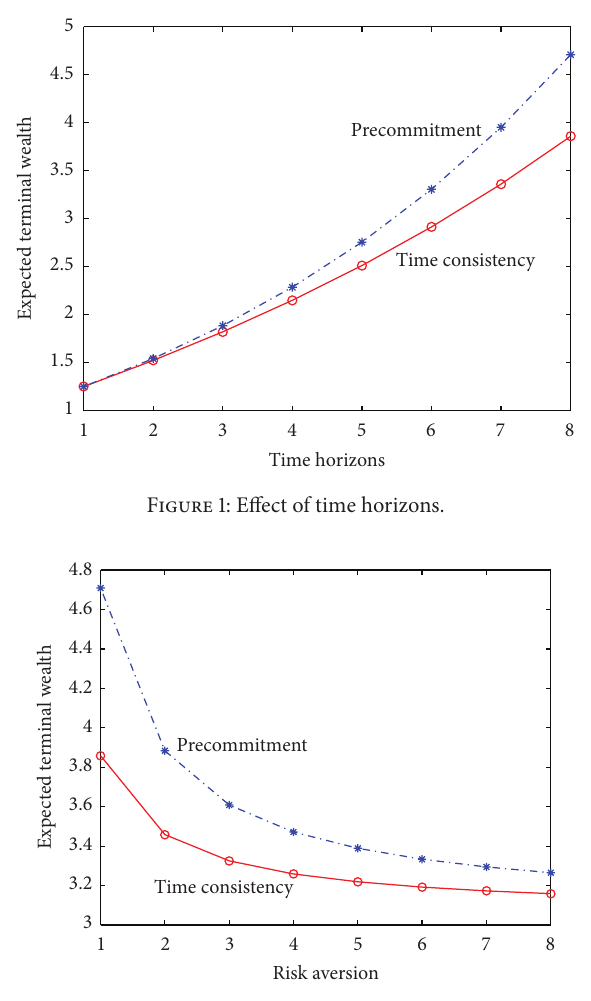
Figure 2: Effect of the risk aversion.